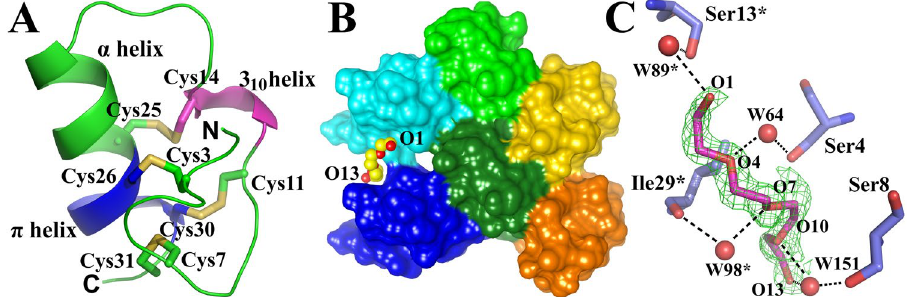
Figure 4. The three-dimensional structure of lyba2. ( A ) Cartoon view of the overall structure. Four disulfide bonds are formed by Cys3–Cys26, Cys7–Cys31, Cys11–Cys30 as well as Cys14–Cys25. The 3 10 helix and π helix are colored purple and blue, respectively. ( B ) Packing of the 3 copies of lyba2 and their symmetry-mates in the crystal. Molecules A, B and C are colored green, pink and blue, respectively. The polyethylenglycol (PEG) molecule is shown in sphere view. The terminal oxygen atoms of the PEG are labeled. ( C ) Details of the interactions between PEG and lyba2. An Fo-Fc electron density of the PEG molecule (green; contoured at 2.5 σ level) is displayed. Hydrogen bonds between the PEG and lyba2 are indicated as dashed lines. Symmetry-related water molecules and amino-acid residues are labelled by an asterisk ( *